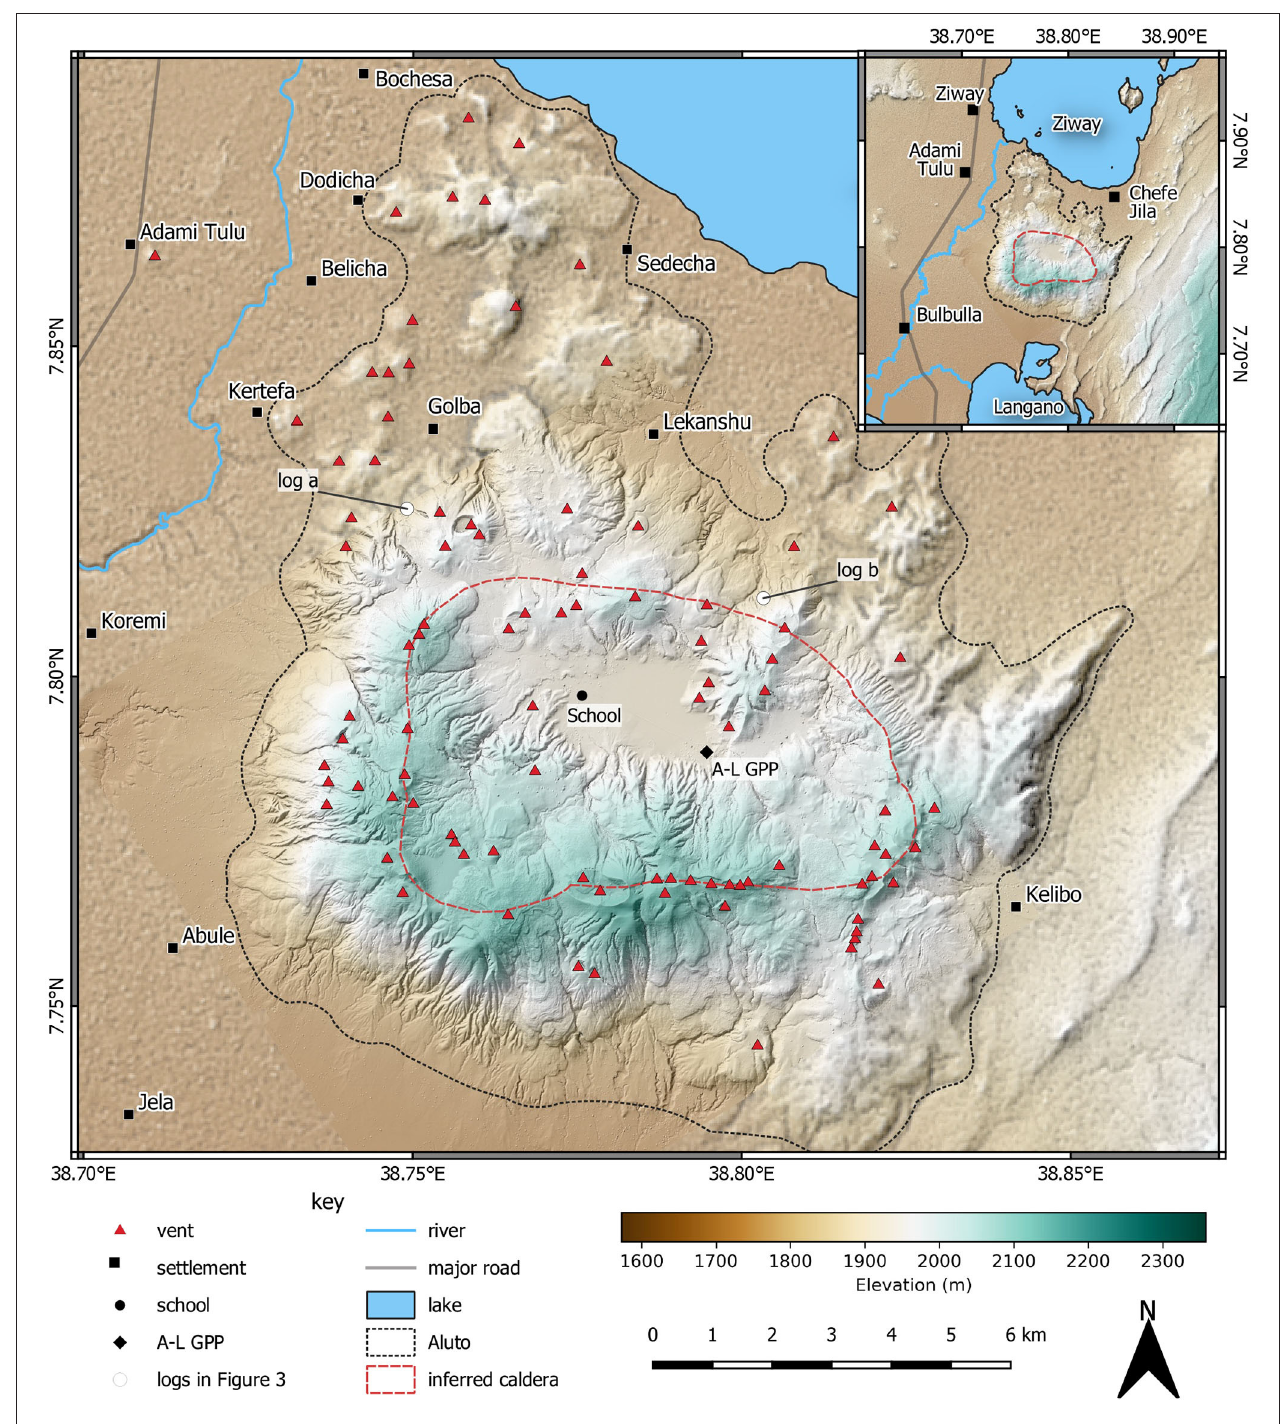
FIGURE 1 | Topographic and regional maps of Aluto volcano showing the location of the 96 pumice cone vents visible at the surface in context. The vents are most concentrated around the inferred caldera ring fault, and cross-cutting regional faults (not shown) around Aluto (Hutchison et al., 2015). The vents were identified from the LiDAR model of Hutchison et al. (2014) and field investigations detailed in Clarke (2020). Named settlements according to regional mapping data are provided, but are by no means exhaustive. “A-L GPP” Aluto-Langano Geothermal Power Plant. Geodetic system/projection: WGS84/UTM Zone 37N (ESPG:32637). =